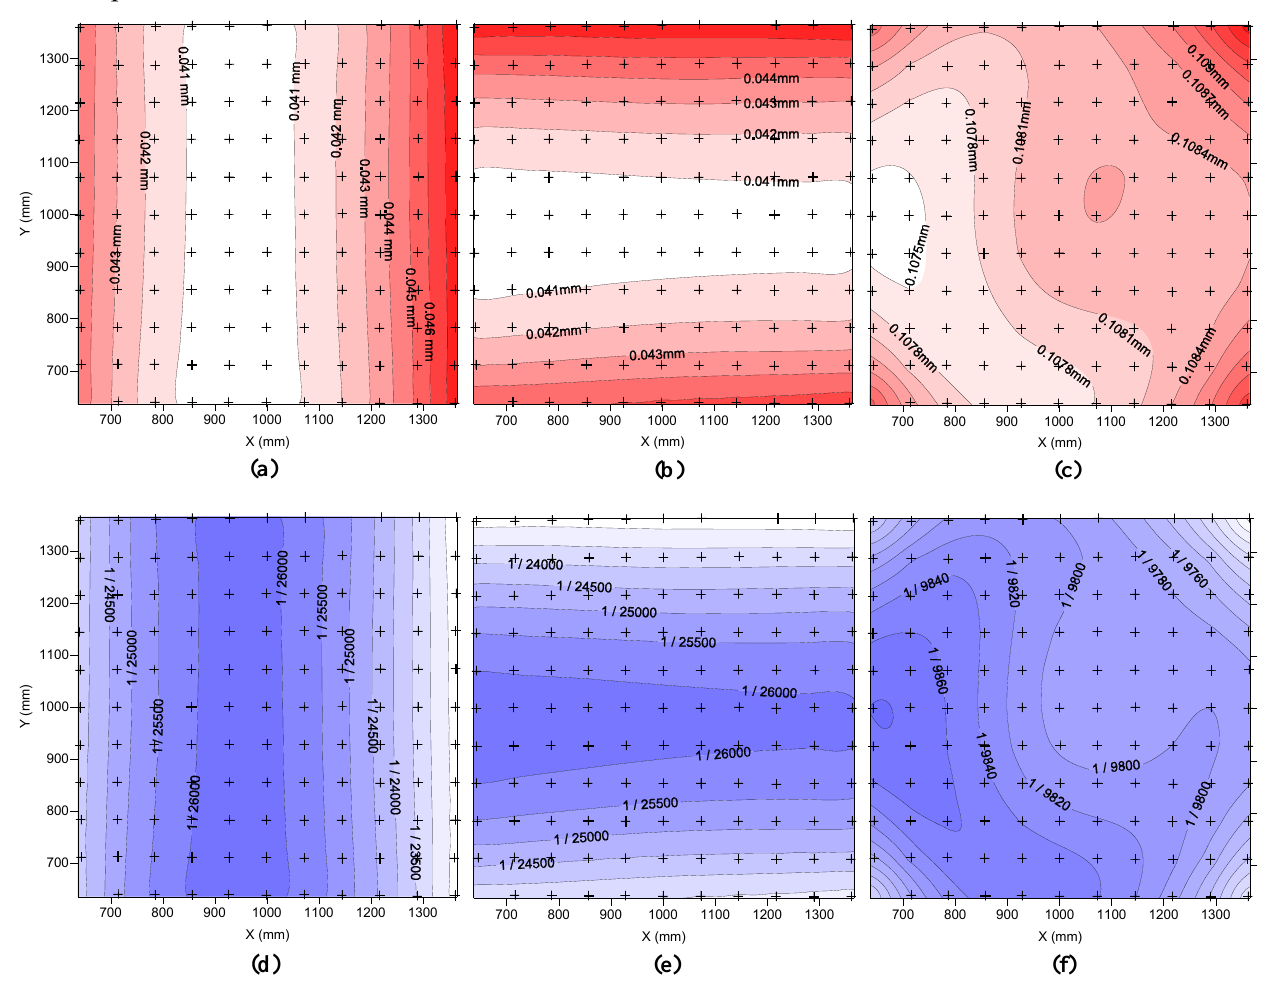
Figure 6. Spatial distribution of standard deviation (mm) obtained in the field test in the direction of X (a), Y (b) and Z (c) using old sets of modelling parameters for the cameras. In (d), (e) and (f) standard deviation in the direction of X, Y and Z, respectively, is represented in relative